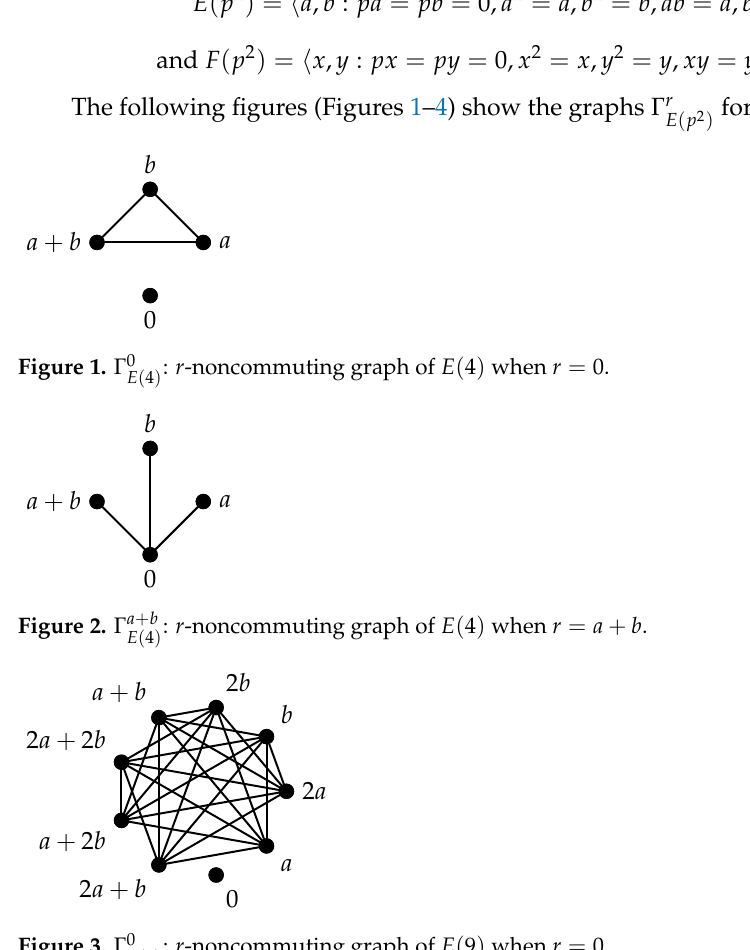
Figure 3. Γ 0 : r -noncommuting graph of E ( 9 ) when r = E ( 9 )